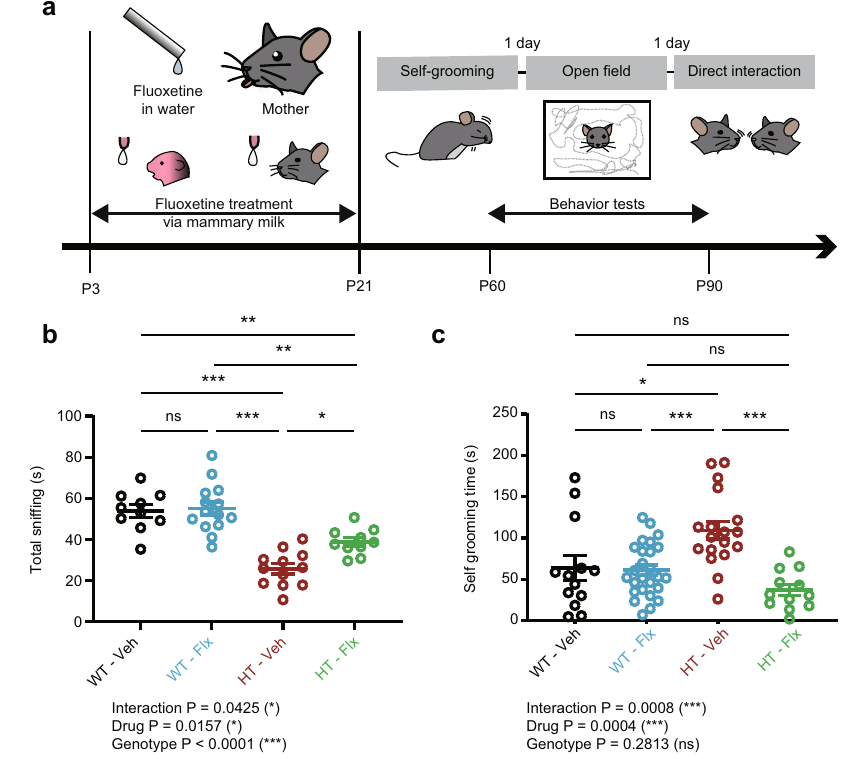
Fig. 4 | Early, chronic fl uoxetine treatment prevents social and repetitive behavioral de fi cits in adult Arid1b +/ – mice. a Schematic diagram showing early, chronic fl uoxetine treatment (P3 – 21) through mother ’ s milk and tests of its long- lasting effects on self-grooming,open- fi eldactivity, and direct social interactionin adulthood (P60 – 90). b Early, chronic fl uoxetine prevents social defects in adult Arid1b +/ – mice, measured using the direct/dyadic social-interaction test (as shown by time spent snif fi ng the social target) without affecting social interactions in WT mice. ( n =10 mouse pairs [WT-Veh], 14 [WT-Flx], 12 [HT-Veh], 10 [HT-Flx], two-way ANOVA with Tukey ’ s test, [WT-Veh vs HT-Veh: p <0.0001, WT-Veh vs WT-Flx: